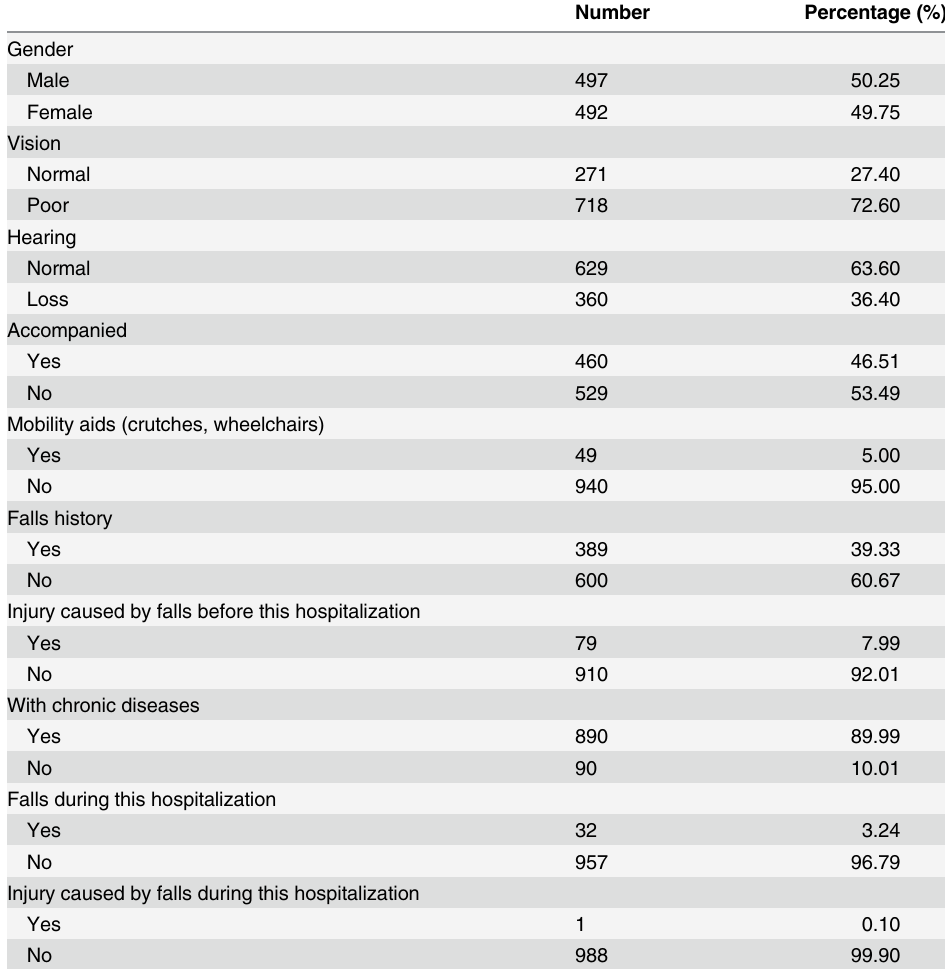
Table 1. Baseline characteristics of study